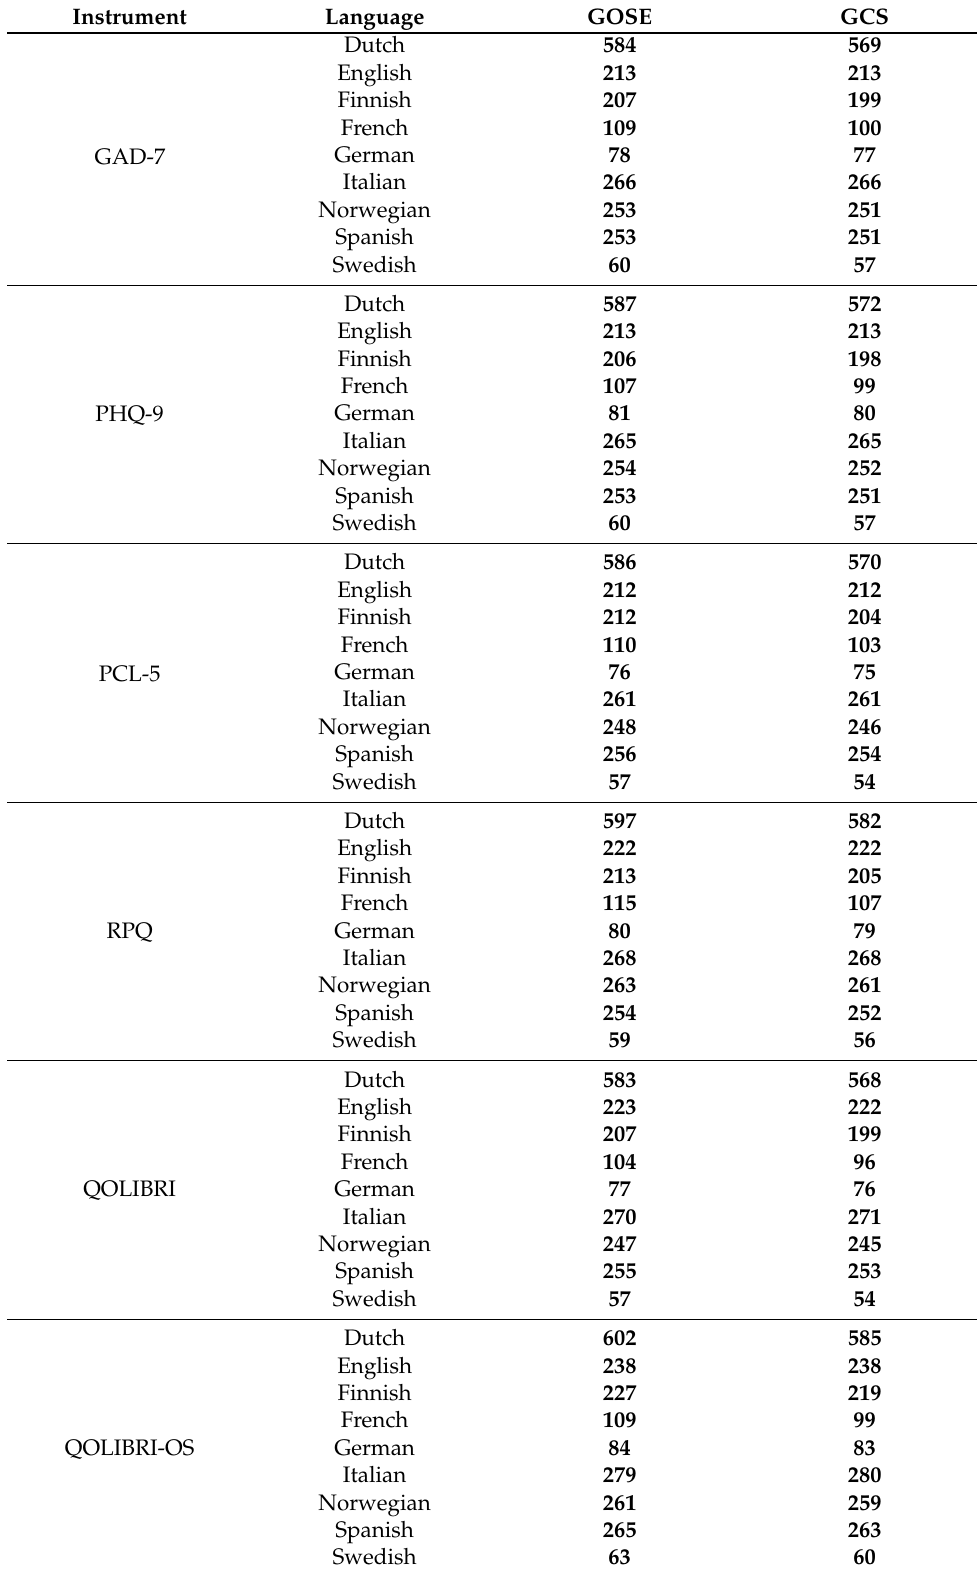
Table A1. Number of participants for convergent (assessed with the GOSE) and discriminant (assessed with the GCS) validity per language and outcome